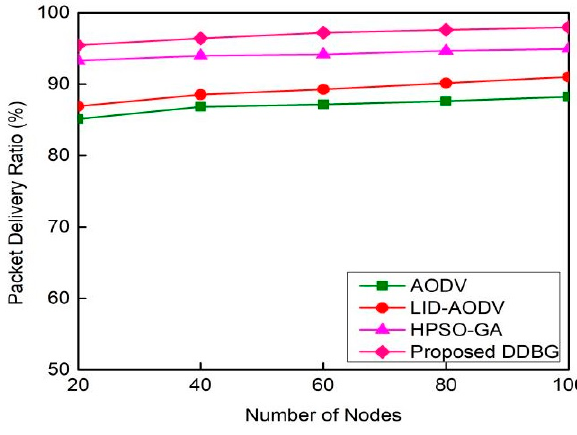
Figure 5. The packet delivery ratio (%). Table 5. The packet delivery ratio evaluation